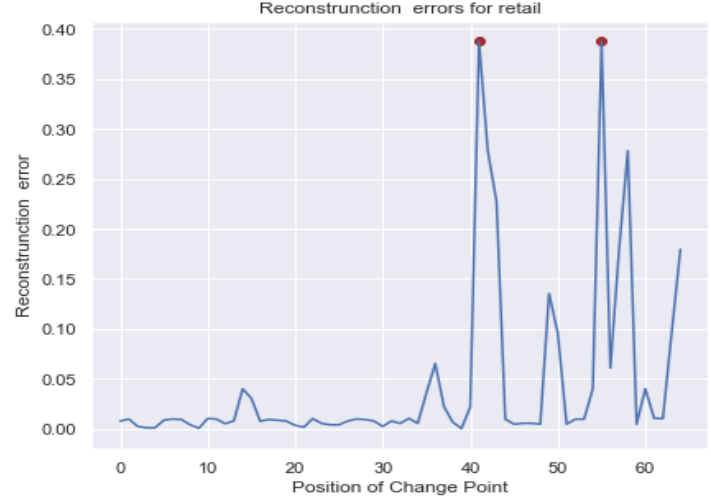
Figure 5. Reconstruction errors for retail and recreation.